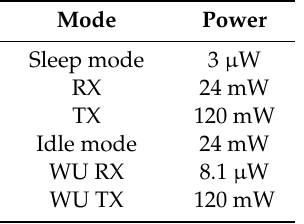
Figure 6. Multi-hop network topology abstraction.